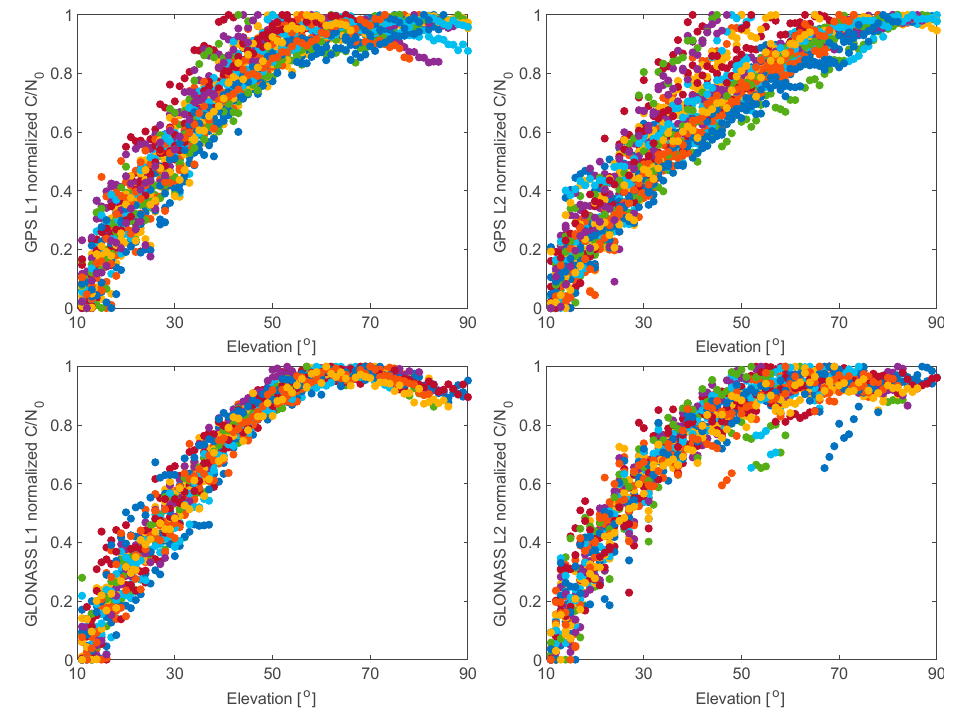
Figure 8. The normalized SNR time series for SHM5.